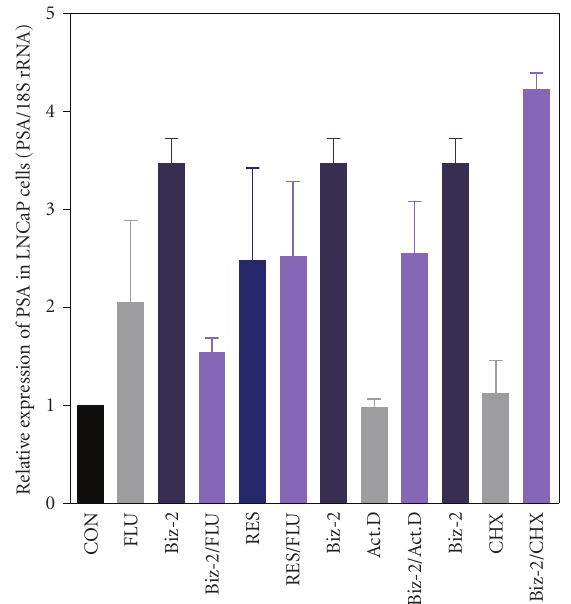
Figure 3: Flutamide inhibition of Biz-2 stimulation of PSA mRNA expression. LNCaP cells were induced with Biz-2 in the presence or absence of flutamide, and RNA from induced or uninduced cells was subjected to two-step Taqman real-time RT-PCR. Rel- ative quantitation of PSA mRNA expression was preformed as described in Figure 2. CON: vehicle control; FLU: flutamide; Biz-2: Bizzy nut extract-2; RES: resveratrol; Act.D: actinomycin-D; CHX: cycloheximide. The values are the mean ± SEM of three separate experiments performed in